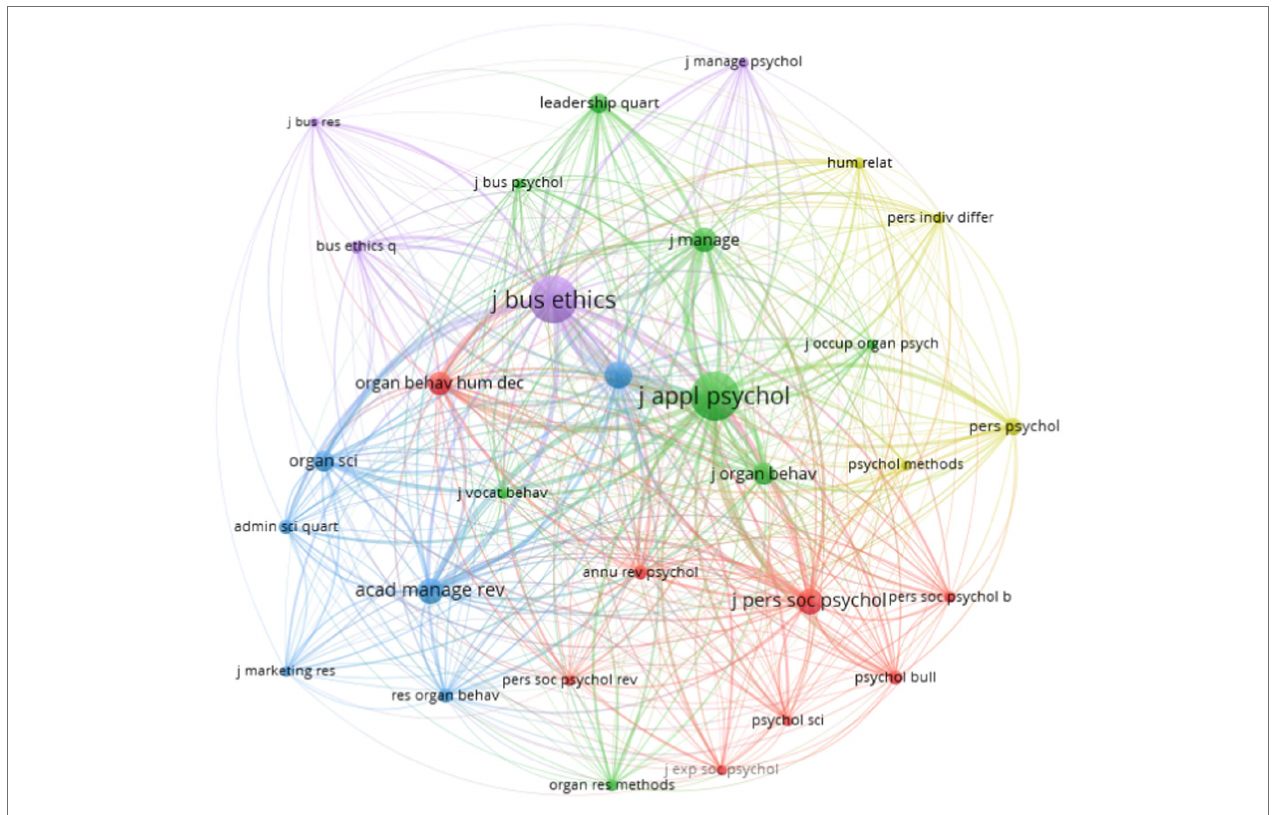
FIGURE 5 | Co-cited journals in UPB